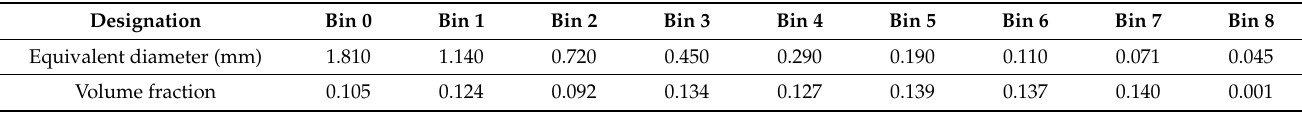
Figure 8. Volume fraction of flocs of each equivalent particle size among the total flocs. Table 2. CFD–PBM coupling simulation floc parameters.